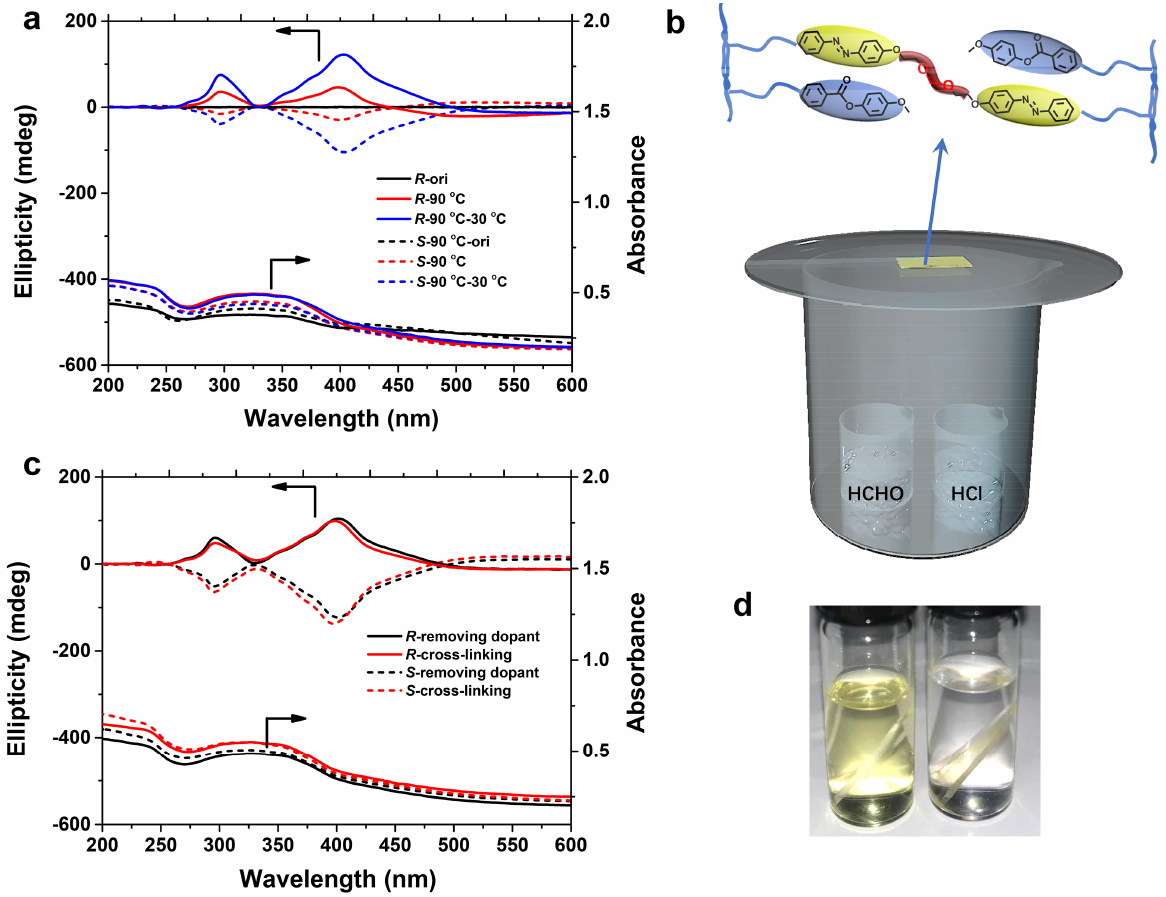
Figure 5. ( a ) CD and UV-vis spectra of the copolymer (PPB- r -AzOH) films doped with PB- R / S 1. ( b ) Schematic diagram of the reaction method during the cross-linking process. ( c ) CD and UV-vis spectra of the chiral films after removing chiral dopants and after cross-linking reaction. ( d ) Pictures of the chiral polymer films placed in THF solution (left, before cross-linking; right: after